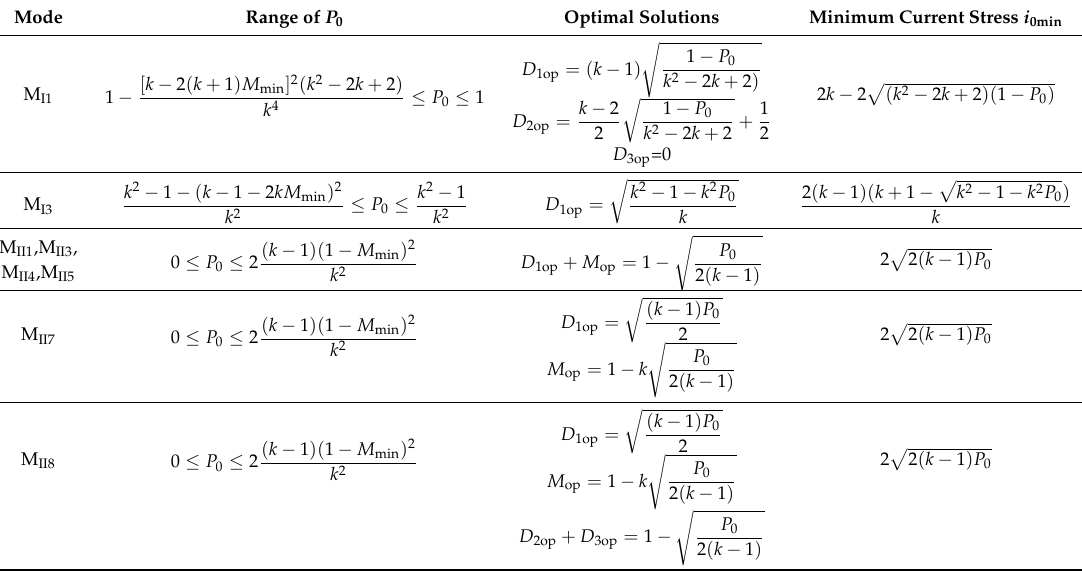
Table 2. Optimal Solutions of Each Mode Calculated by Lagrange multiplier method (LMM).